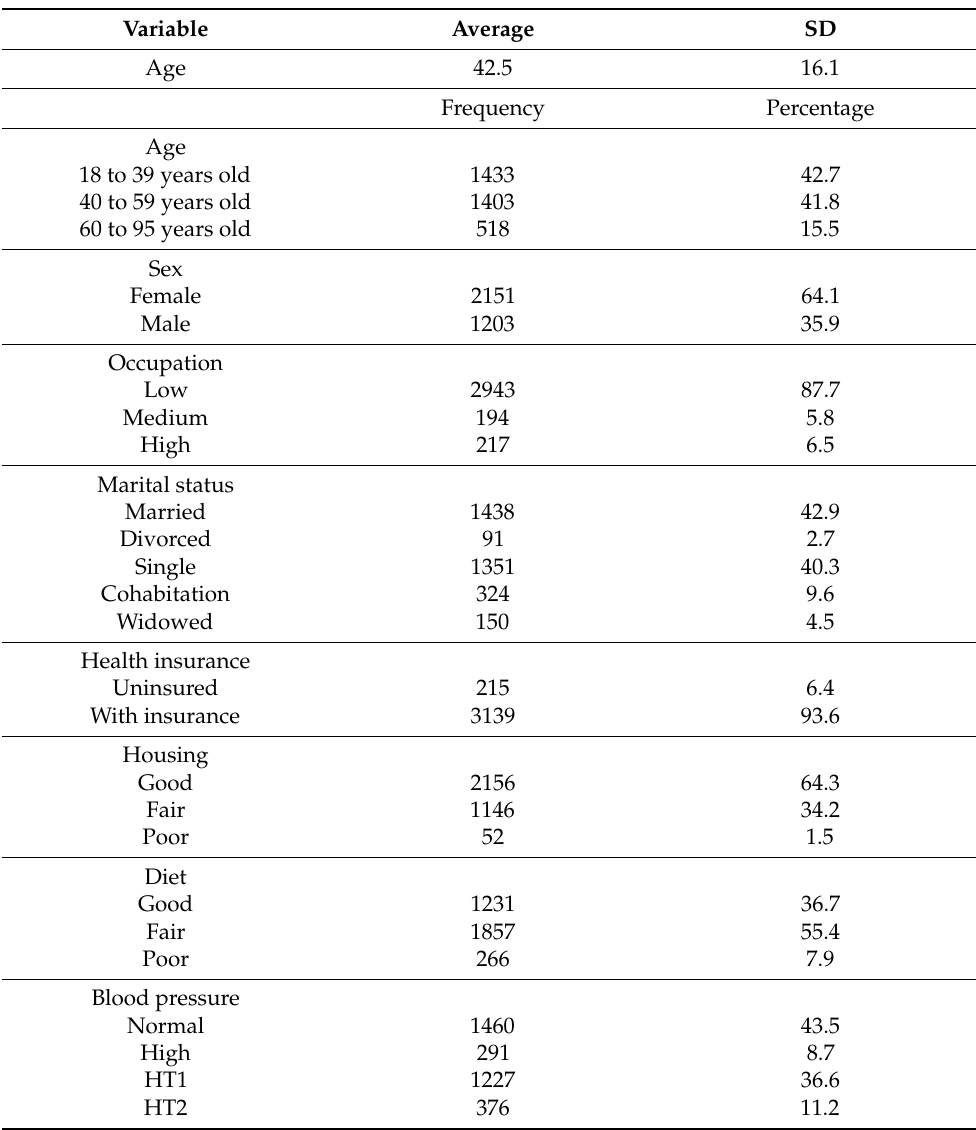
Table 1. Descriptive characteristics of the study